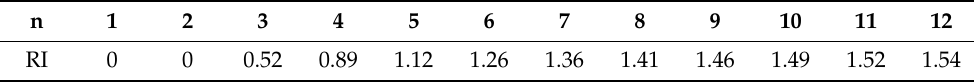
Table 2. The random average consistency